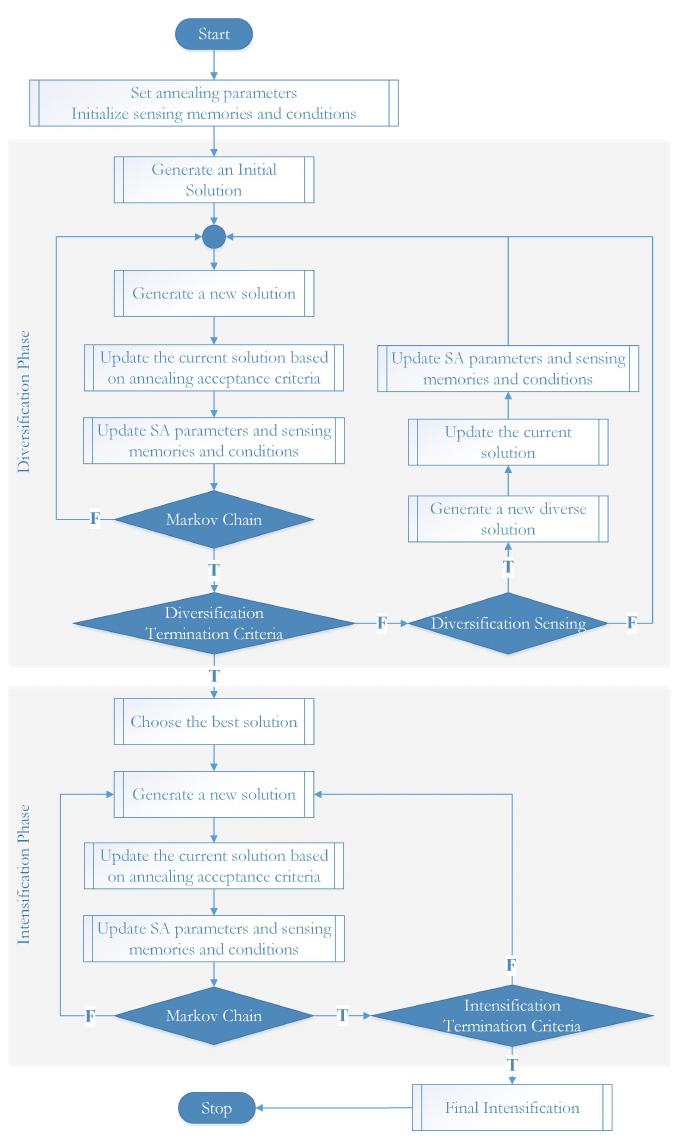
Figure 2. Flowchart of the proposed